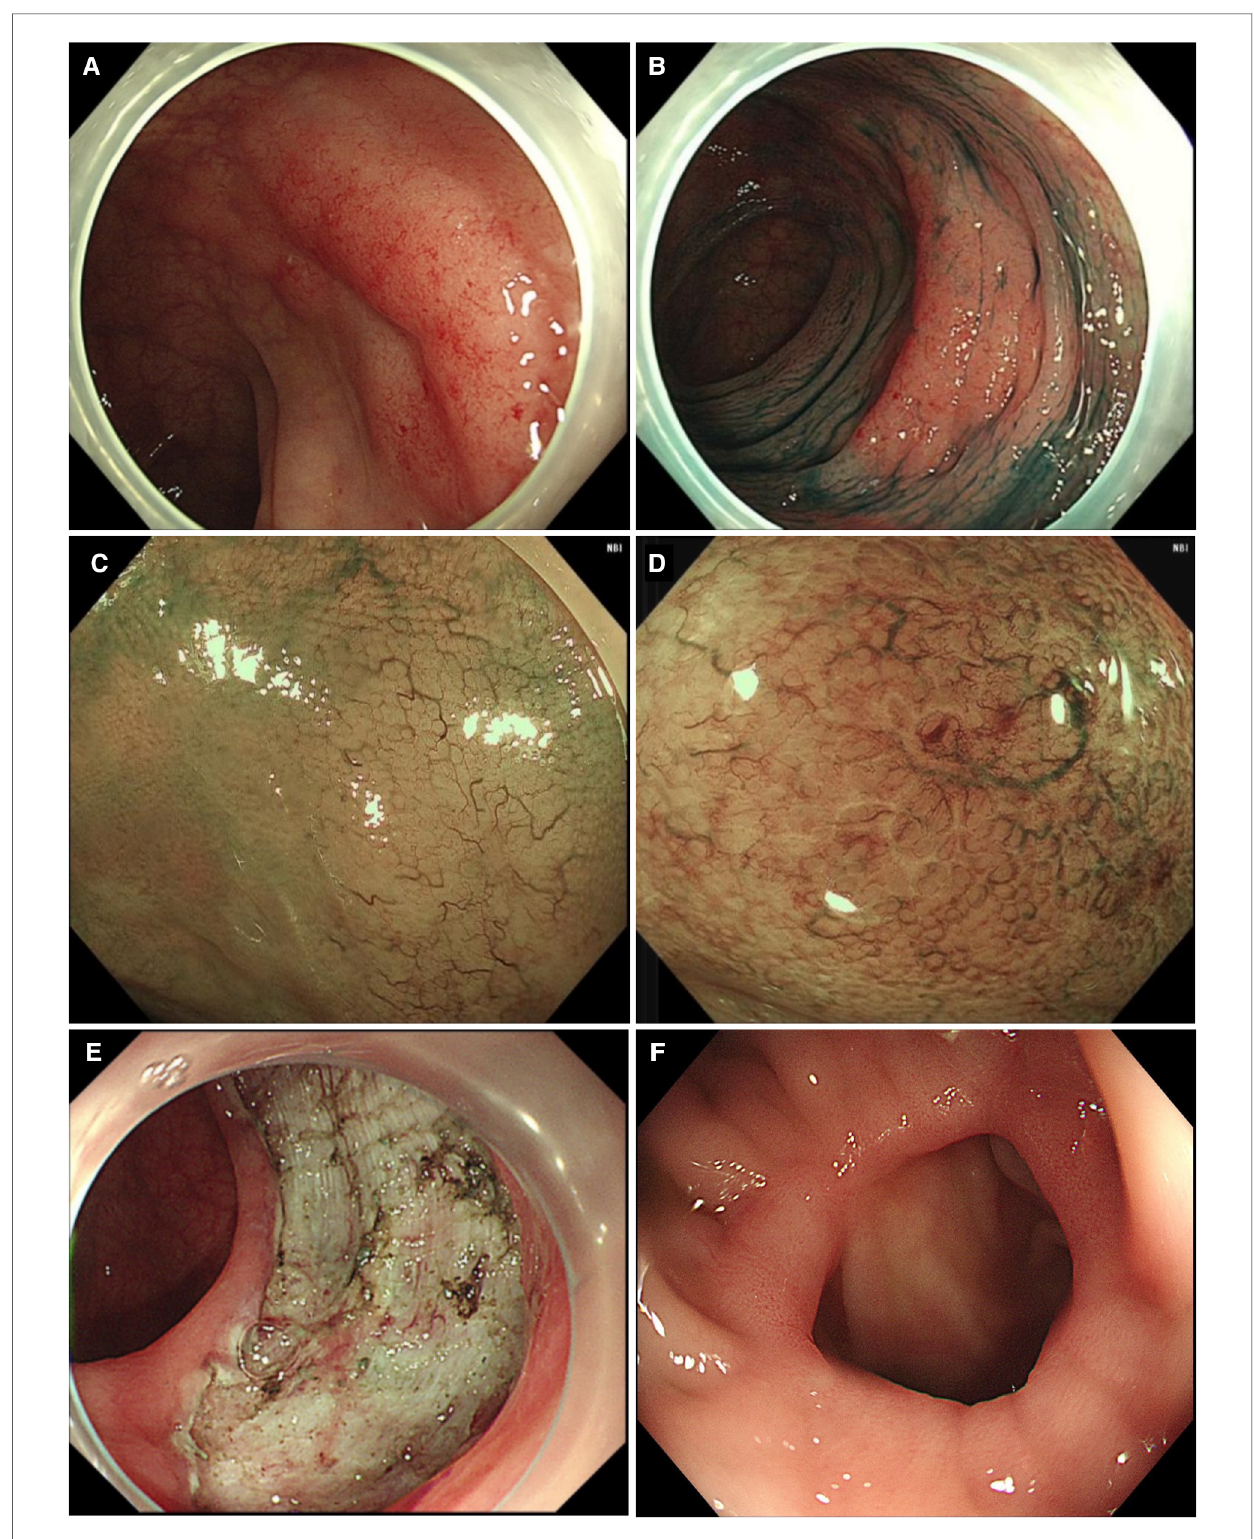
FIGURE 1 Clinical data of the patient with colonic mucosa – associated lymphoid tissue lymphoma. ( A ) Normal colonoscopy shows a 0-IIb-type lesion; ( B ) indigo carmine staining; ( C ) narrow-band imaging magnifying endoscopy shows an irregular branching vasculature; ( D ) disappeared glandular structure; ( E ) diagnostic ESD resection of lesions; ( F ) colonoscopy results after the